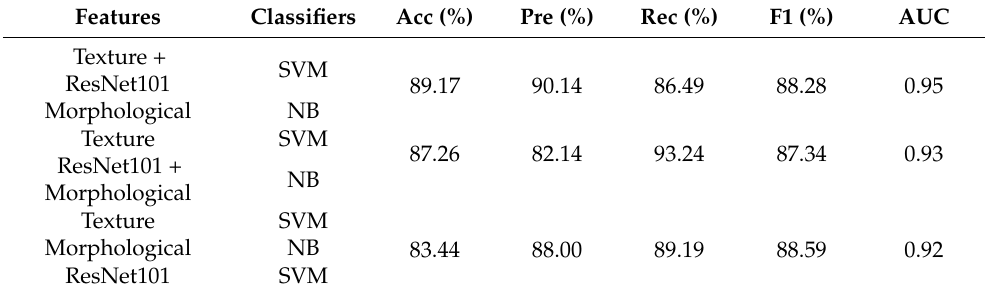
Table 4. The classification results with different features combined with different